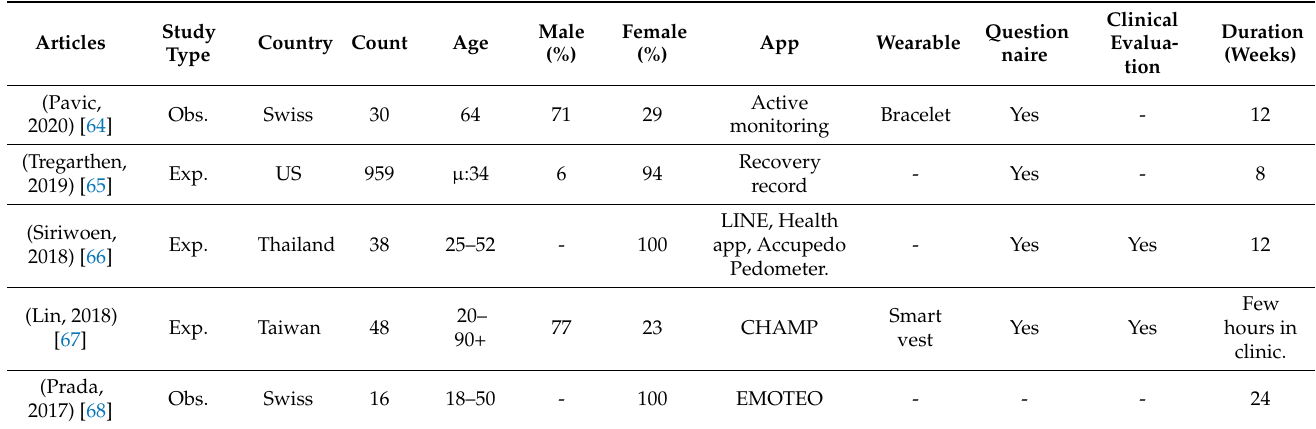
Table 2. Characteristics of included